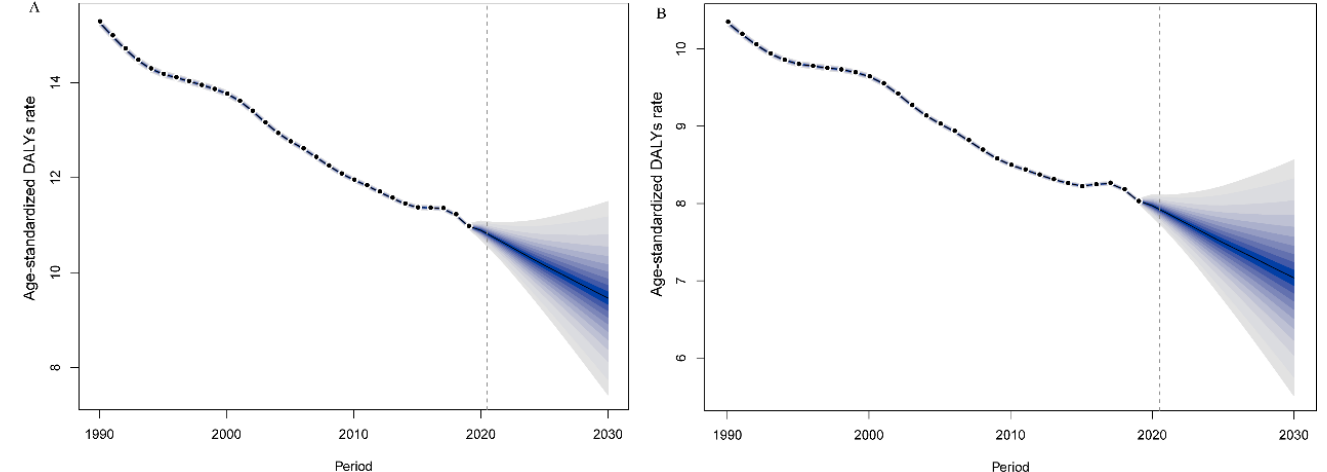
Figure 4. Trends in age-standardized DALY rates from 2019 to 2030 in males ( A ) and females ( B ) predicted by Bayesian age – period – cohort (BAPC) models. DALY: disability-adjusted life-year.